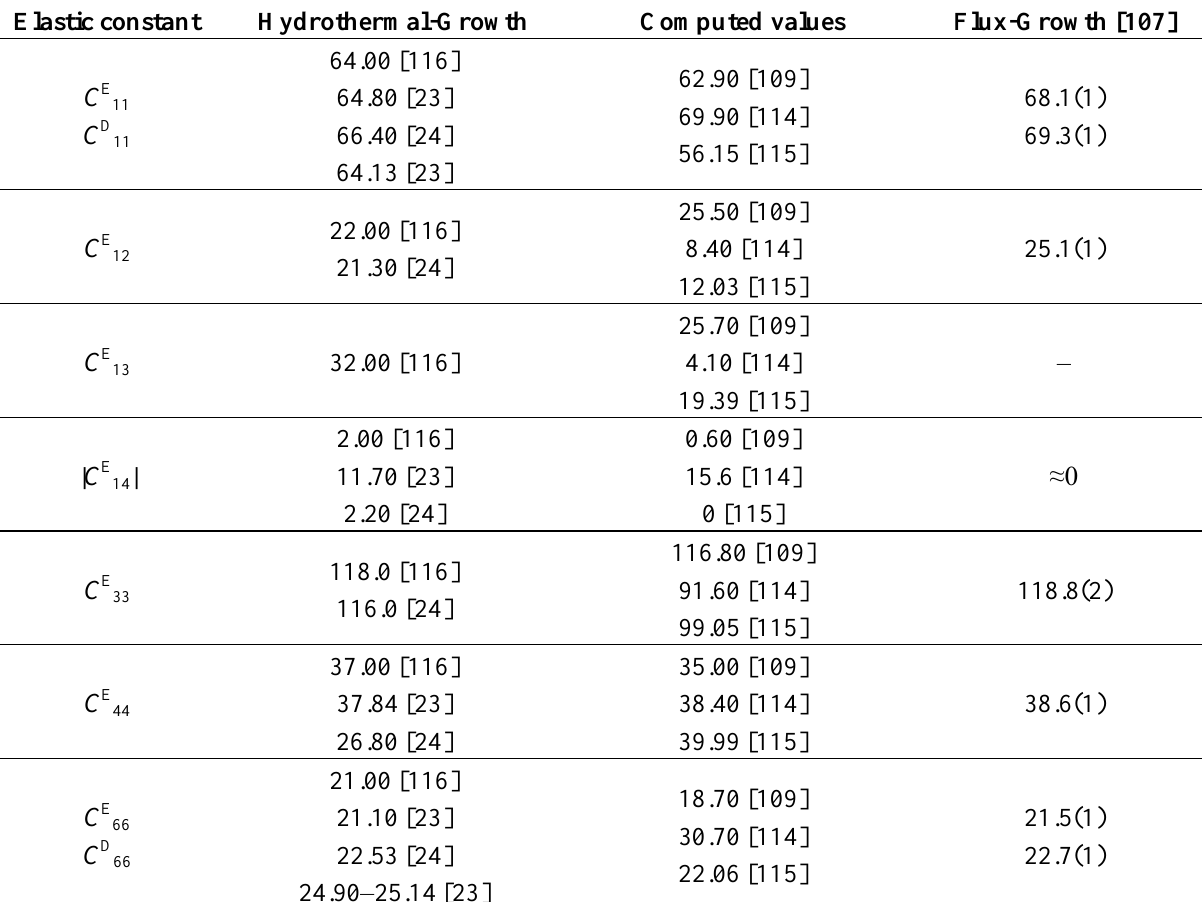
[GPa] of α-GeO . IJ 2